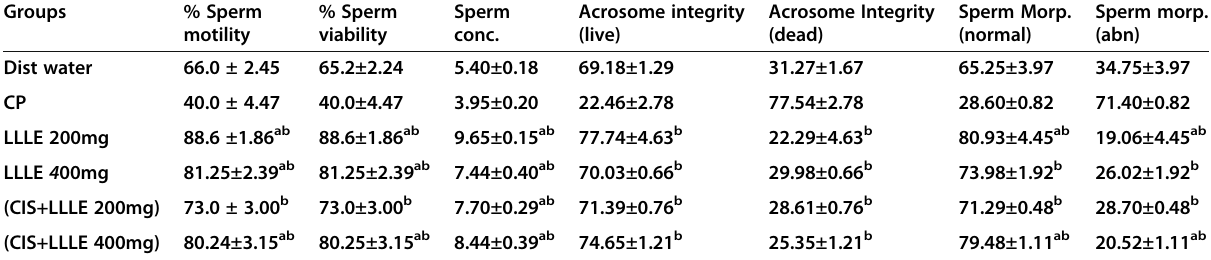
Table 3 Protective effects of oral administration of LLLE for 26 days on sperm parameters of CP treated male Wistar rats Groups